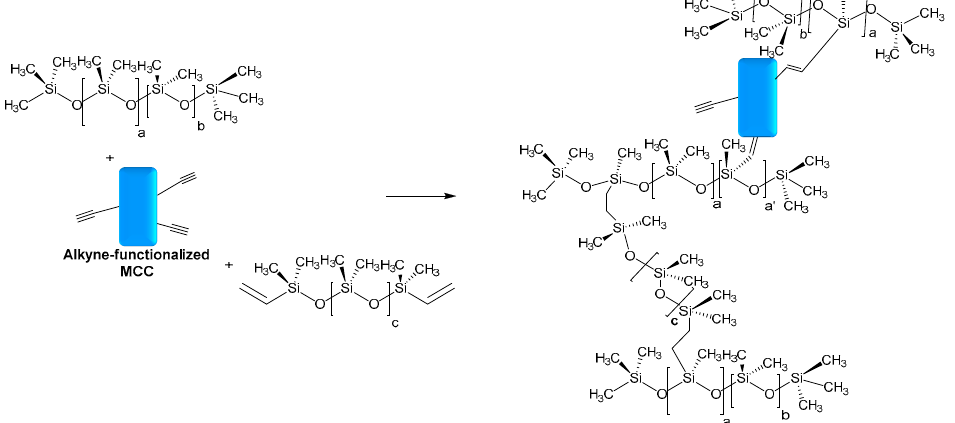
Figure 11. Possible hydrosilylation reaction occurring between alkyne-functionalized MCC and hydride-functional PDMS.